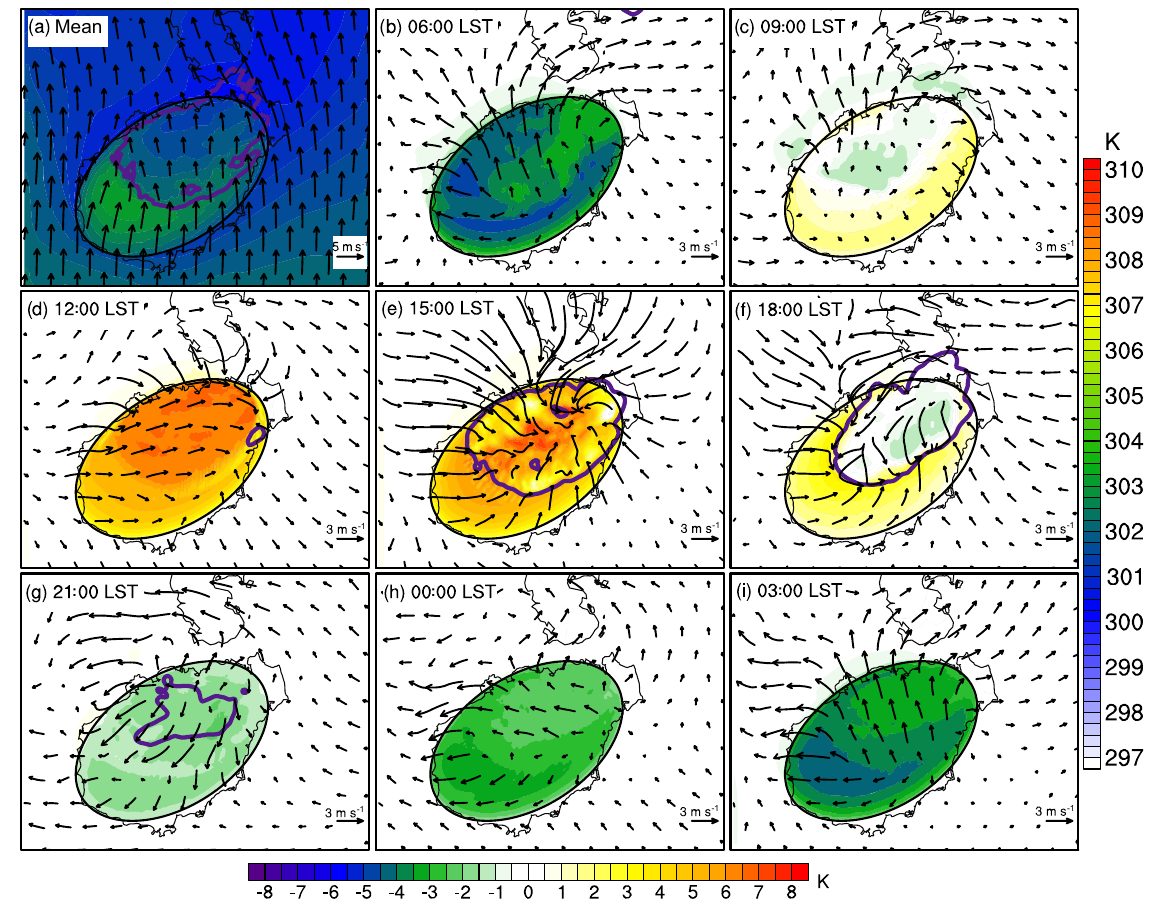
Figure 12. (a) 2m mean temperature (shading) and horizontal wind (vectors) on the second-lowest model level for horizontal wind; (b–i) 2m mean temperature perturbation (shading) and mean perturbation horizontal wind (vectors) on the second-lowest model level every 3h. The right color bar is used for (a)